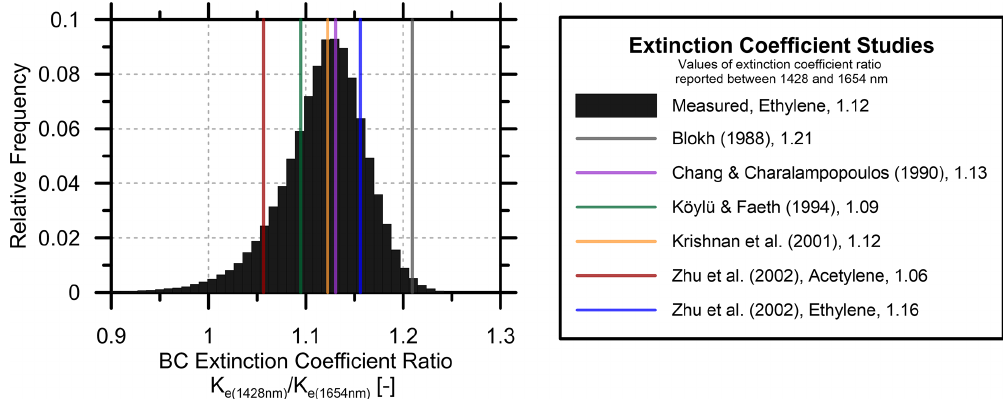
Figure A4. Distribution of estimated K e ratio between 1428 and 1654nm during ethylene flare test. The measured mean BC extinction coefficient ratio was 1.12 (standard error of the mean of 1 . 3 × 10 − 4